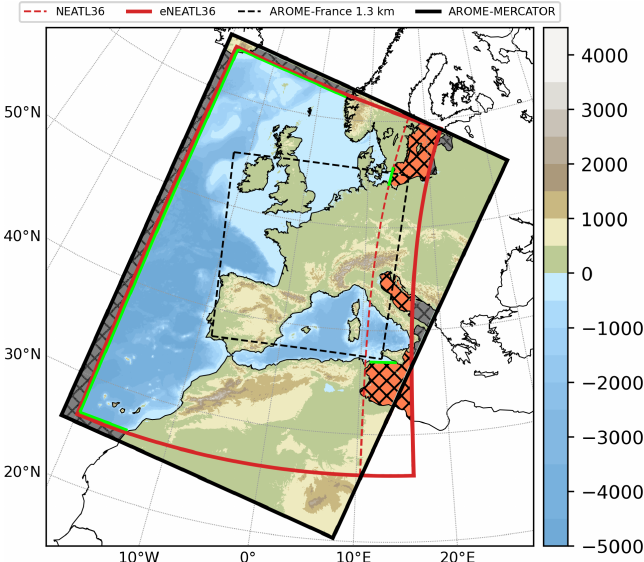
Figure 1. Simulation domain illustrated by the bathymetry (m) in NEMO (in blue) and by the orography (m) of the AROME model (in green-brown colours). The lines indicate the extension of the NEMO-eNEATL36 configuration (red) and of the AROME-Mercator domain (black); the green lines highlight the open boundaries in the oceanic model. For AROME-Mercator, the grey and orange marine zones are always uncoupled (constant initial SST and null current are used; see text). For eNEATL36, the orange marine zones are not solved in the regional oceanic simulations. The dashed lines indicate the boundaries of the actual operational configurations of AROME (AROME-France, 1.3km resolution, in black) and NEMO over the Iberia–Biscay–Ireland (IBI) region (NEATL36, 1/36 ◦ resolution, in